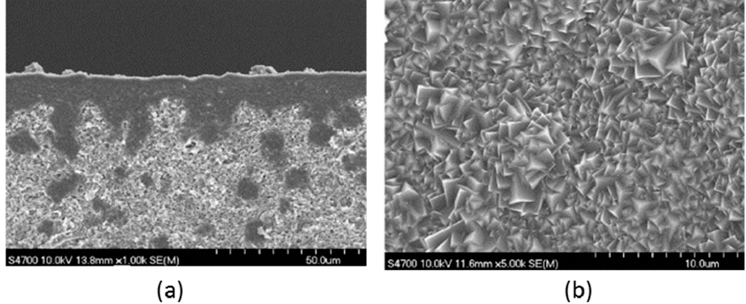
Figure 13. SEM images of ( a ) cross-section and ( b ) top-surface of NaA zeolite membrane [266]. The support material is porous glass-ceramic (silica) composite the intermediate layer is grown non-uniformly. Reproduced with permission from